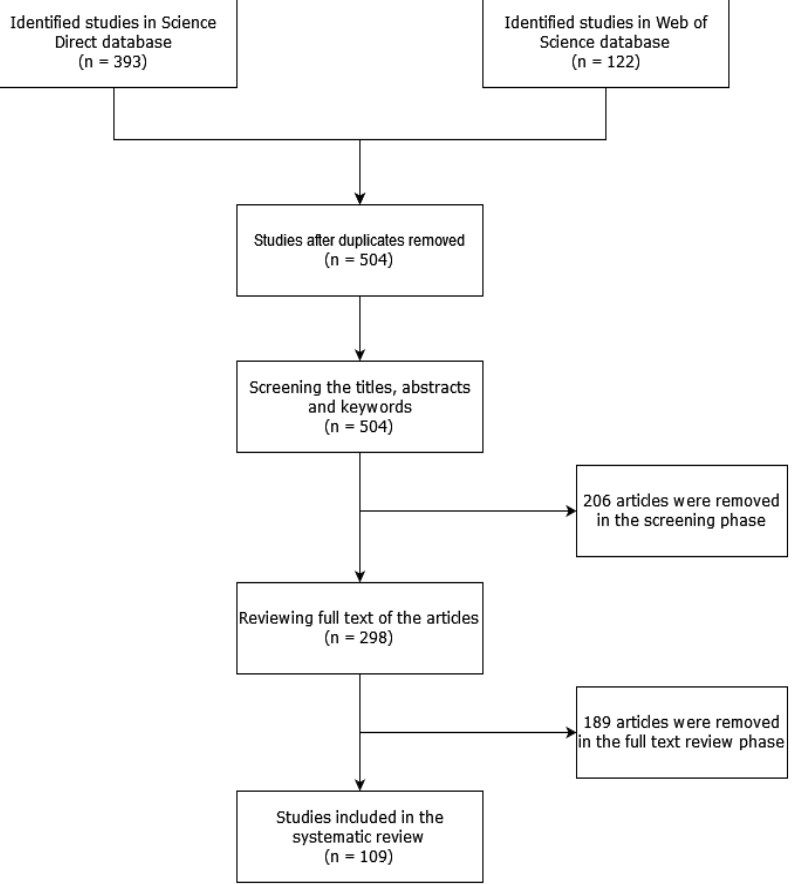
Figure 3. Summary review protocol.